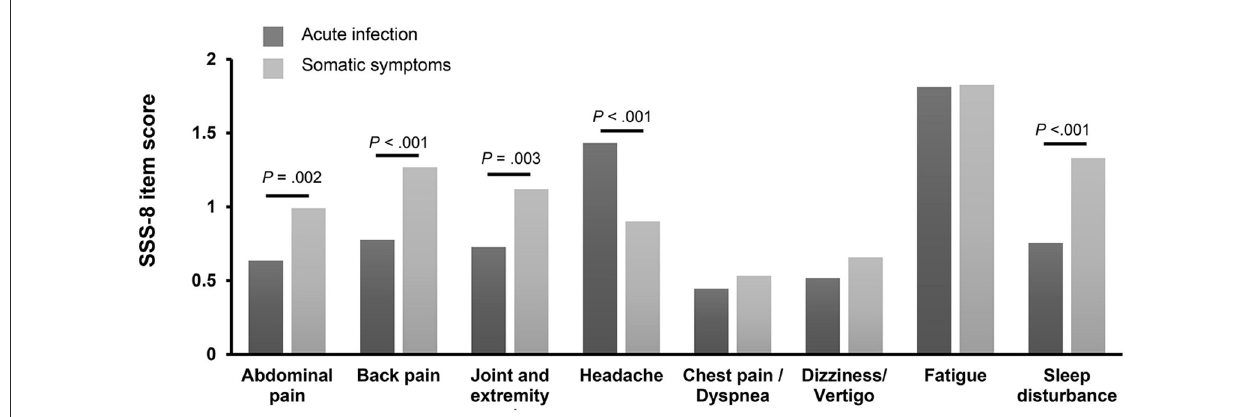
FIGURE2 Comparison of each SSS-8 item score stratified according to symptoms. The figure shows the scores (0 = not at all, 4 = very strongly) for the different symptom dimensions of the Somatic Symptom Scale-8 (SSS-8) stratified for participants of the acute infection group ( n = 139) and participants of the somatic symptom group ( n = 214).